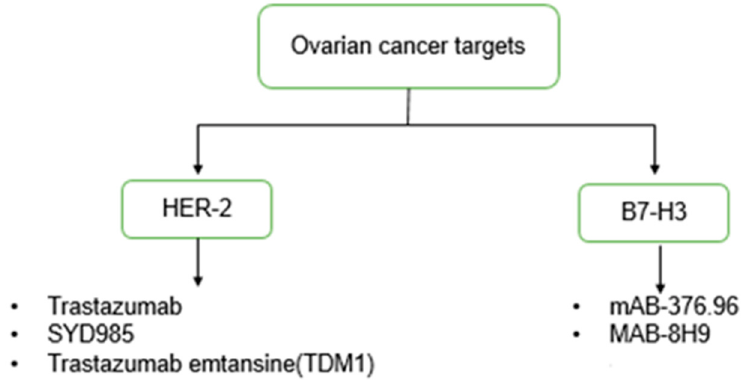
Figure 2. Flow chart representing the two ovarian cancer targets with their respective antibodies [39].